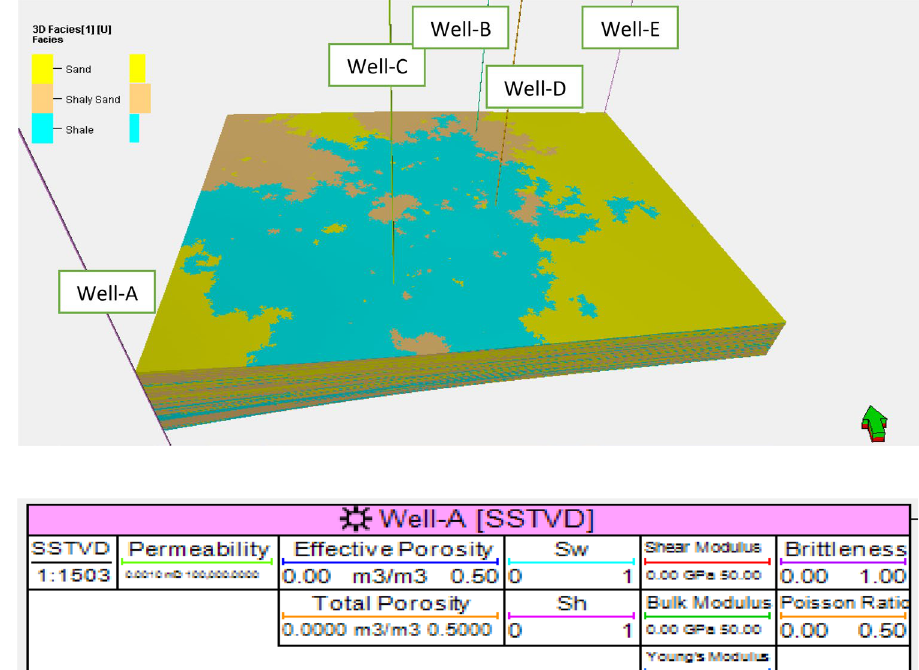
Fig. 12 Petrophysical and geomechanical properties in